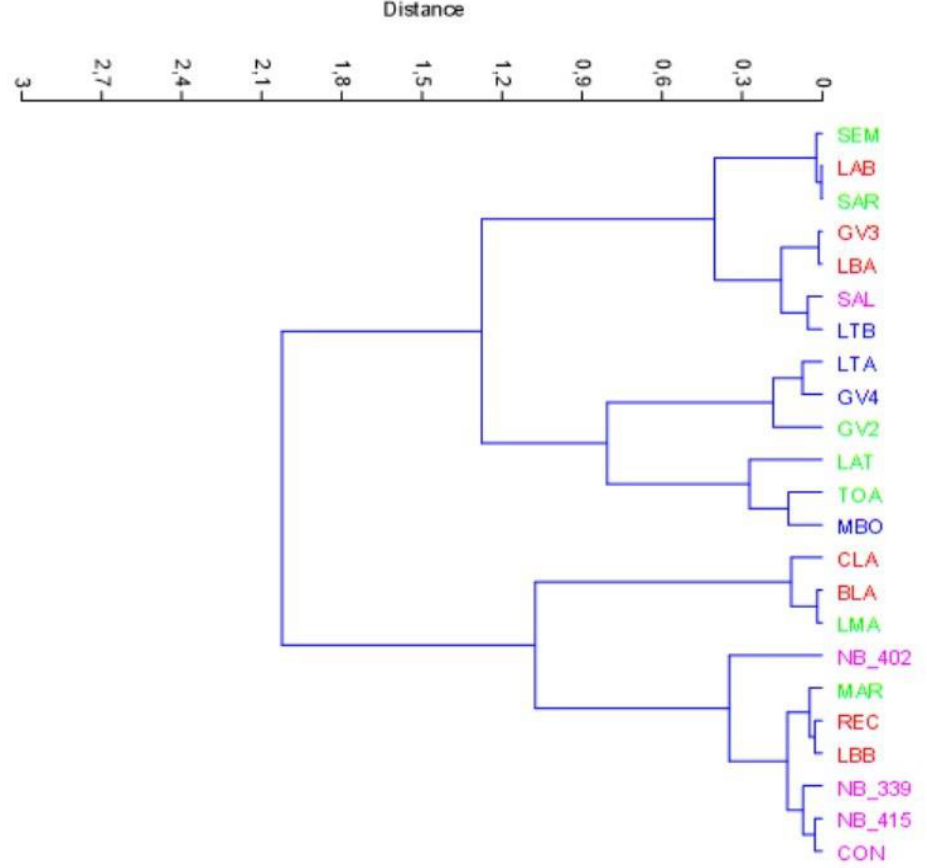
Figure 5. Cluster analysis (aggregative method, Ward’s algorithm, not constrained and Euclidean distance) performed on variables “S_crunch” and “T_noise”. Legend: green, Itrana cv.; blue, Taggiasca cv.; lilac, Nocellara del Belice cv.; red, Bella di Cerignola